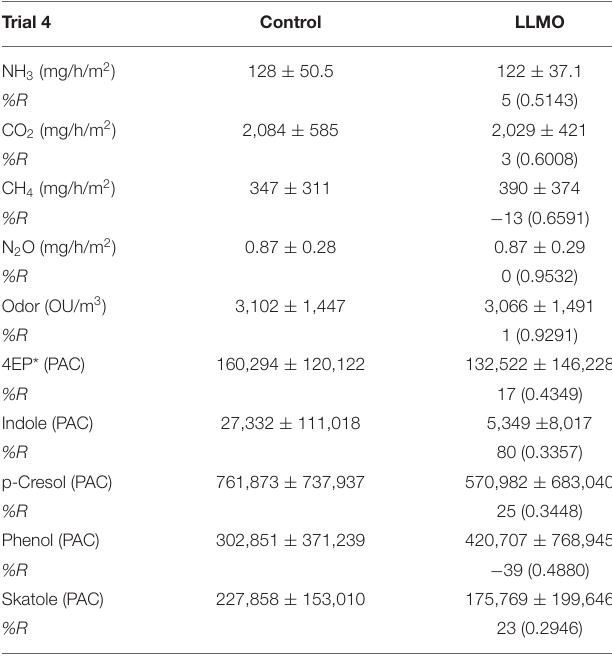
TABLE 8 | Trial 4-comparison of averaged gaseous emissions from three manure sources (farms) with their standard